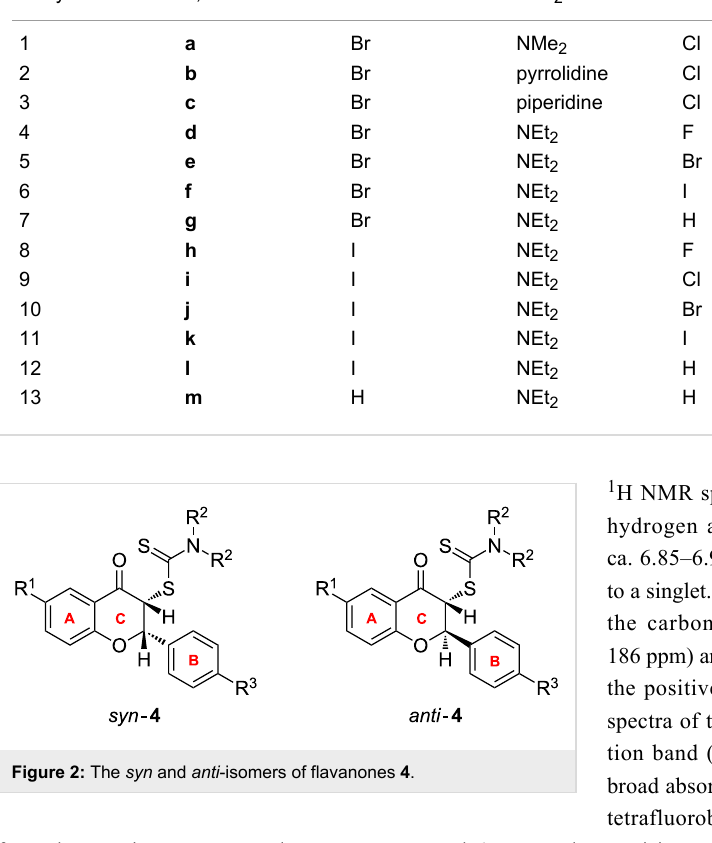
([M − BF 4 ] + ). Single crystals suitable for X-ray analysis were section